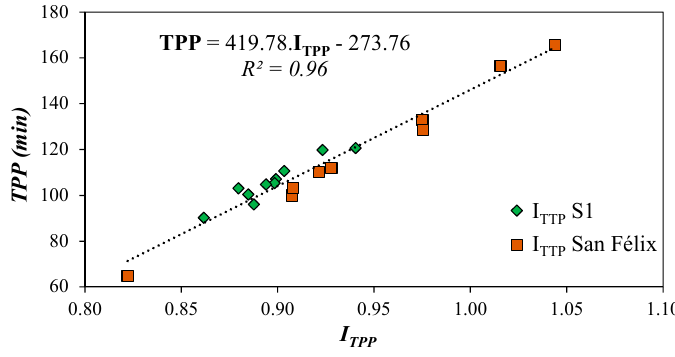
Figure 6. Linear adjustment of TPP with prediction index I TPP .